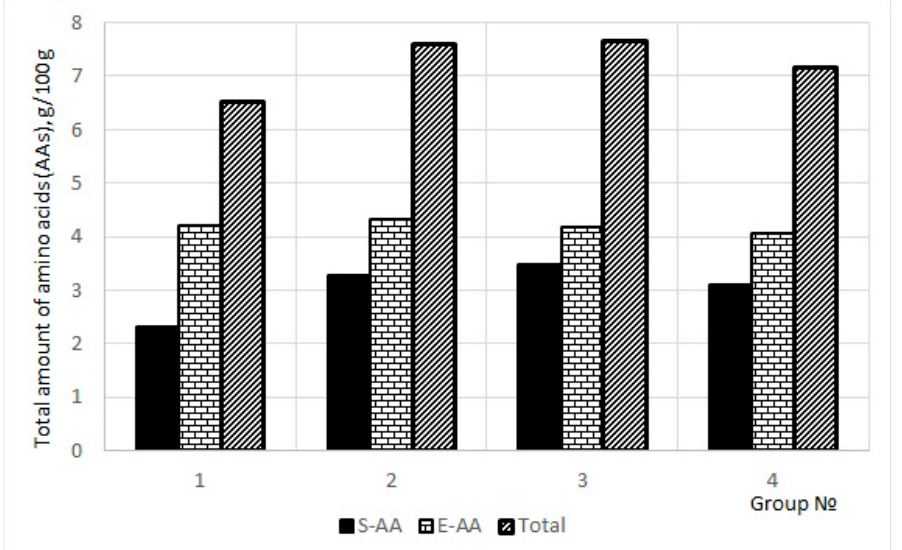
Figure 1. The amount of synthesizable amino acids (S ‐ AA), the amount of essential amino acids (E ‐ AA) and the total amount of amino acids (Total) in pig blood serum in each of the four groups (n = 80) depending on the fattening duration (65–90 days): X ‐ axis—animal groups, Y ‐ axis—the content of S ‐ AA (left black columns); E ‐ AA (middle “stone” hatching columns); total AA (right “oblique” hatching columns).